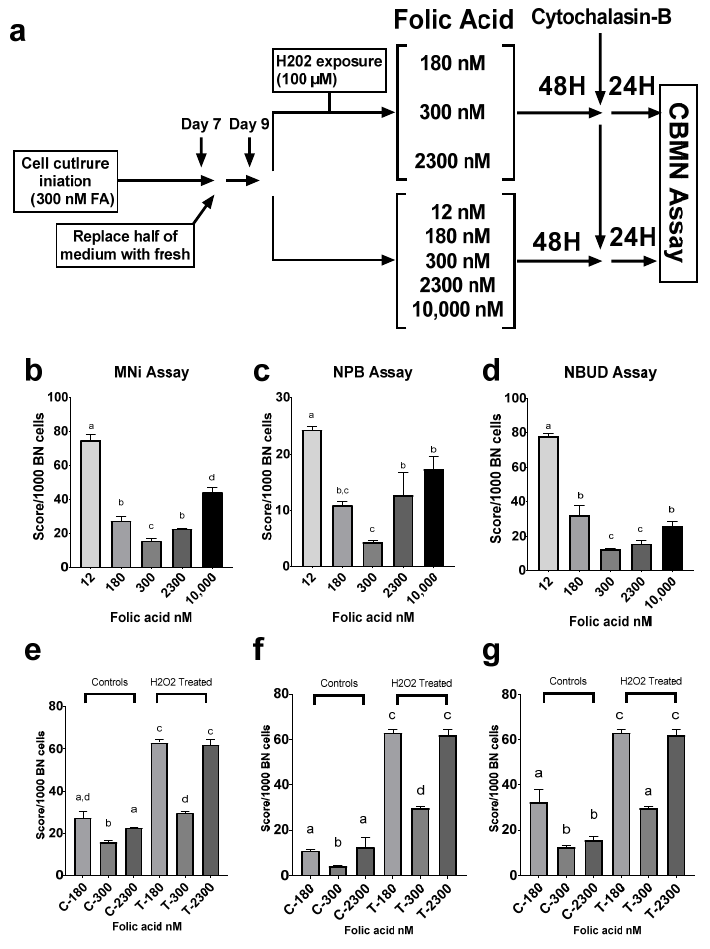
Figure 2. Impact of folate supplementation on markers of genomic damage, measured through CBMN assay in a human lymphoblastoid cell line. ( a ) Study design. ( b ) Effect of FA media concentration on micronuclei occurrence. ( c ) Effect of FA media concentration on the incidence of nucleoplasmic bridges. ( d ) Effect of FA media concentration on nuclear budding. ( e ) Media FA levels impact the incidence of micronuclei in LCLs exposed to hydrogen peroxide. ( f ) Media FA levels impact the incidence of nucleoplasmic bridges in LCLs exposed to hydrogen peroxide. ( g ) Media FA levels impact the incidence of nuclear budding in LCLs exposed to hydrogen peroxide. Results are from technical triplicates ( n = 3). Bars, SEMs, and means with different letters (a,b,c,d) are significantly different (Tukey’s HSD, p < 0.05).